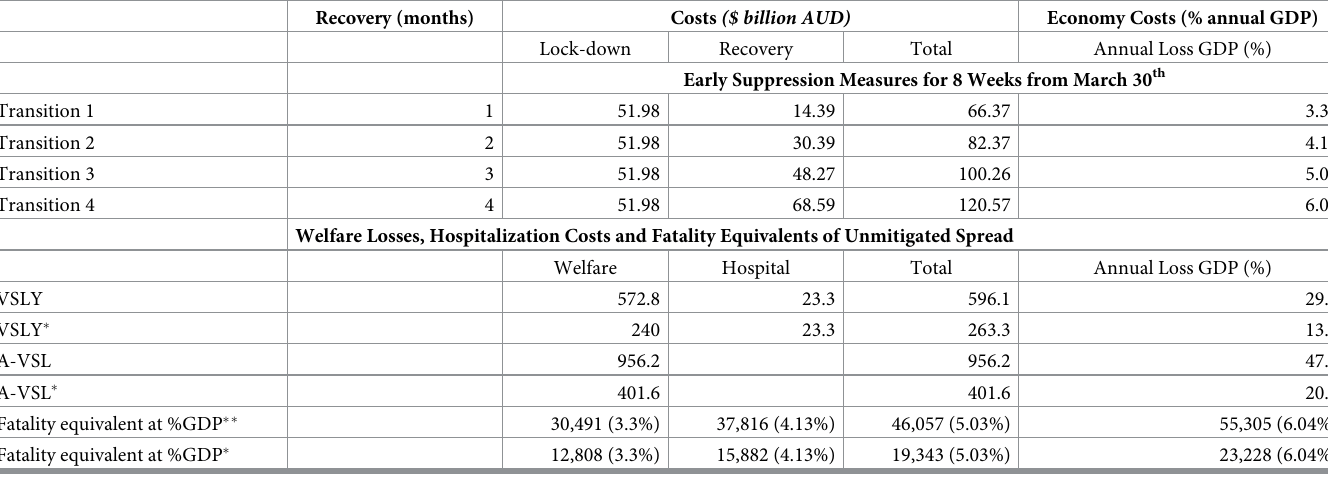
Table 6. Direct economic costs with early suppression in $ billions and GDP loss, and health and welfare